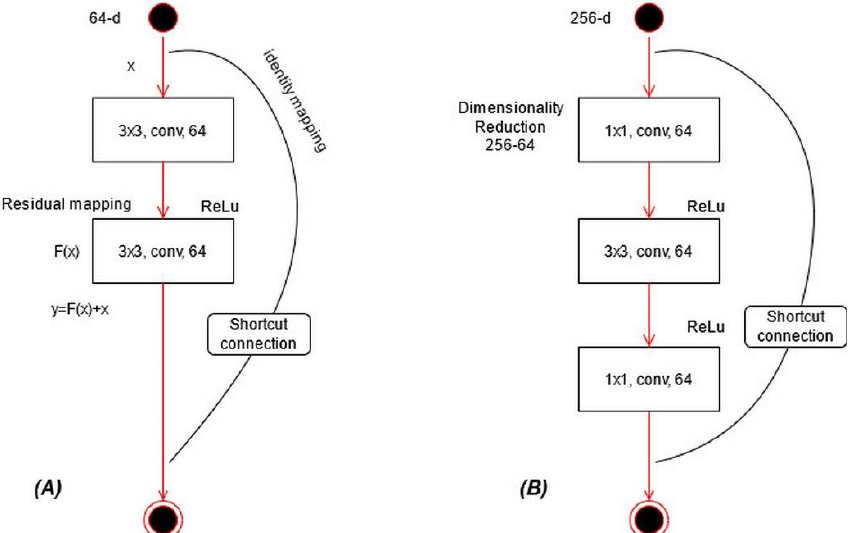
Diagnostics 2021 , 11 , 811 Figure 11. Type of building blocks for ResNet: ( A ) a basic building block, ( B ) a bottleneck block.